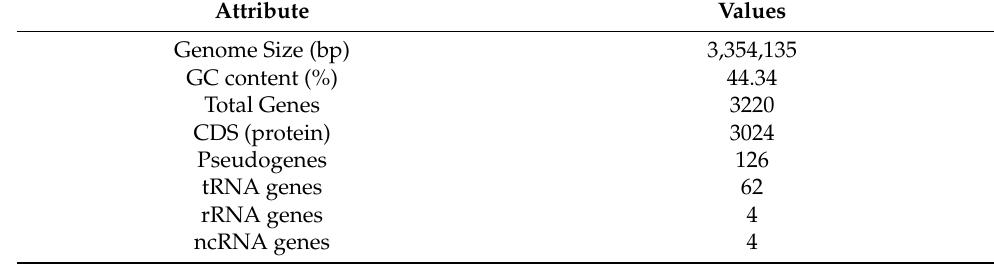
Table 1. L. plantarum L125 genome features.